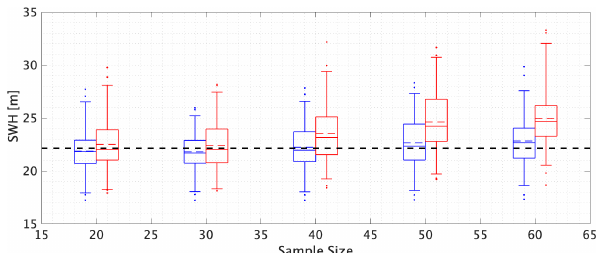
Figure 10. The effect of sample size on estimates of return values for STM. Box–whiskers summarize estimates for the 500-year STM return value based on maximum likelihood estimation (blue) and the method of probability-weighted moments (red), for different sample sizes. The black dashed line gives an empirical estimate of the return value obtained directly from the synthetic cyclone